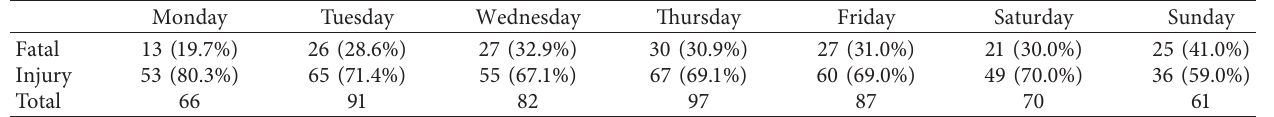
Table 3: Statistical information of different days of the week for injury severity.